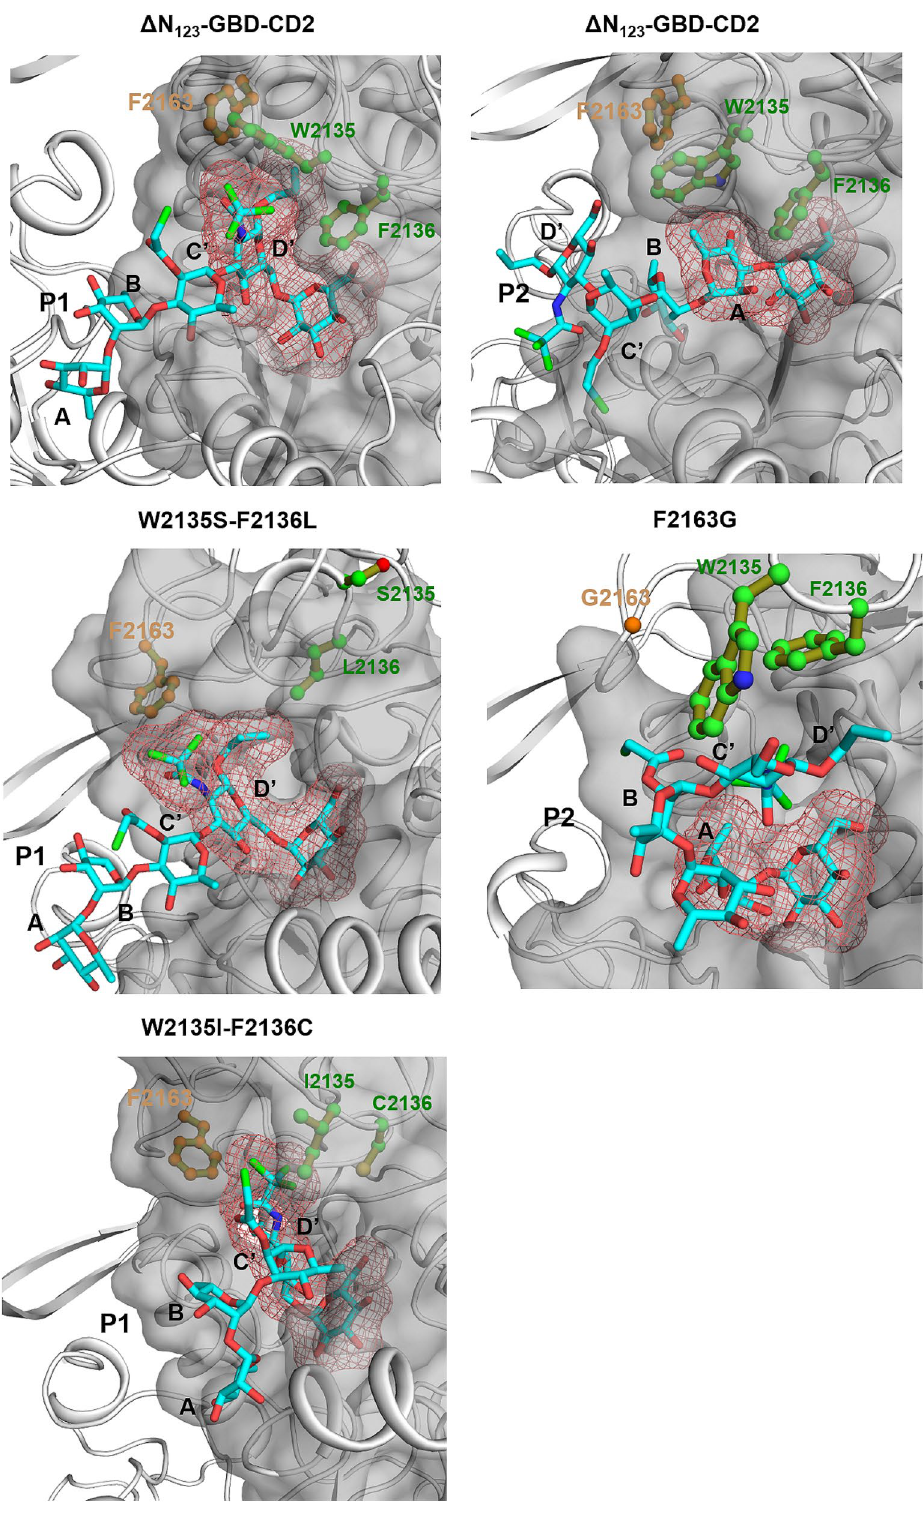
Figure 7. View of the active sites of mutants W2135S-F2136L and W2135I-F2136C in complex with their preferred product P1 (left) and mutant F2163G in complex with favored product P2 (right). Parental ΔN 123 - GBD-CD2 is shown in presence of P1 and P2 for reference purpose. The 3D coordinates were taken from the last frames of the simulated annealing pursued by 2 ns MD simulation of each complex. Molecular graphics were prepared using PYMOL 1.7 (PyMOL Molecular Graphics System, Schrödinger,